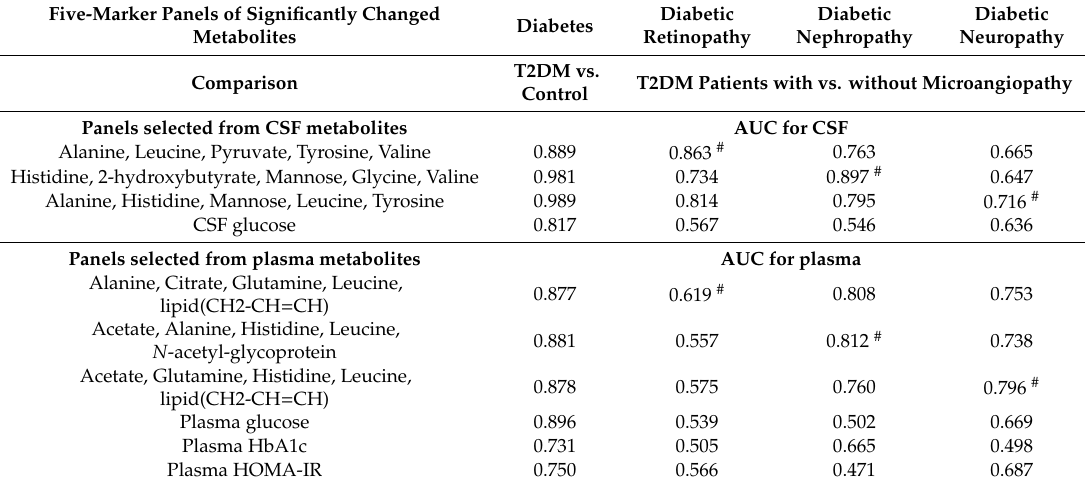
Table 5. Estimated AUC value of five-marker panels for correlation with diabetic microangiopathy among T2DM